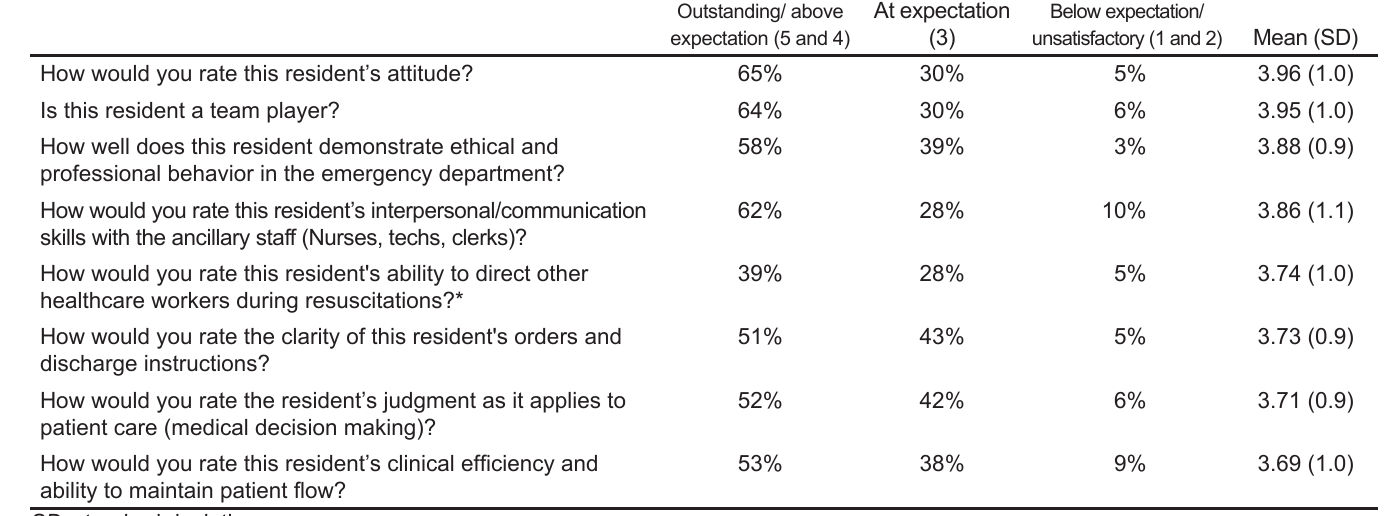
Table 1. Nurses’ quantitative assessments of residents.